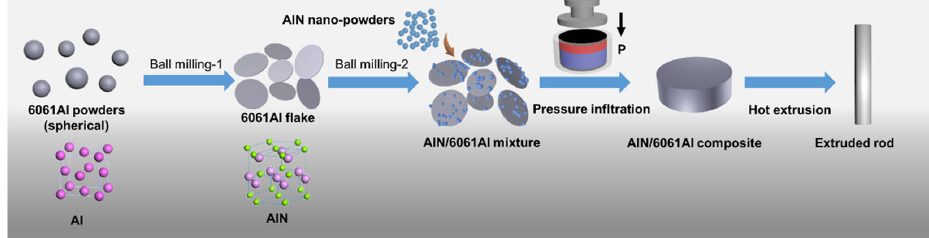
Figure 2. The schematic preparation process of nano ‐ AlN/AA6061 composite.